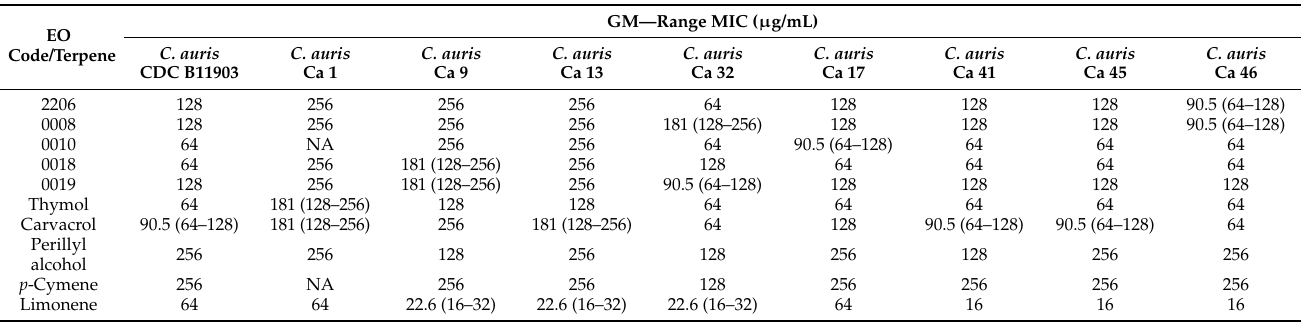
Table 4. Minimal inhibitory concentration values of the most active EOs studied and of some commercial terpenes against C. auris .